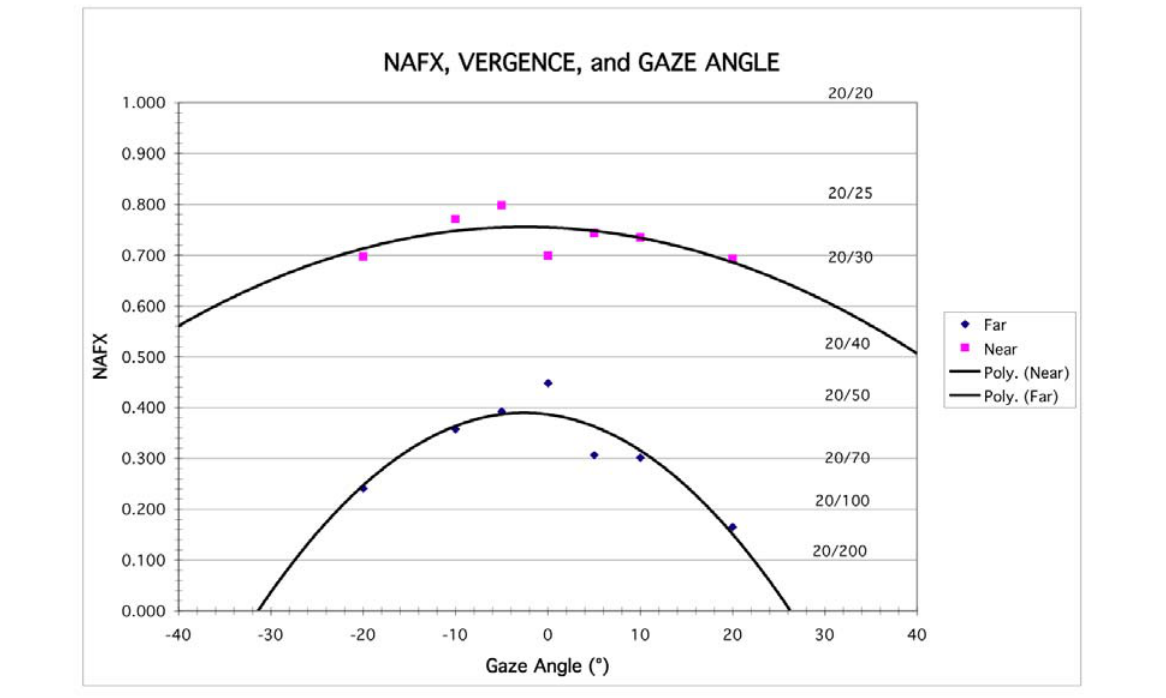
FIGURE 2. NAFX variation with gaze angle for far and near targets. Convergence both raises and broadens the peak NAFX curve. Acuities shown are for patients aged 40–60 years